Question: State the chart type depicted above.
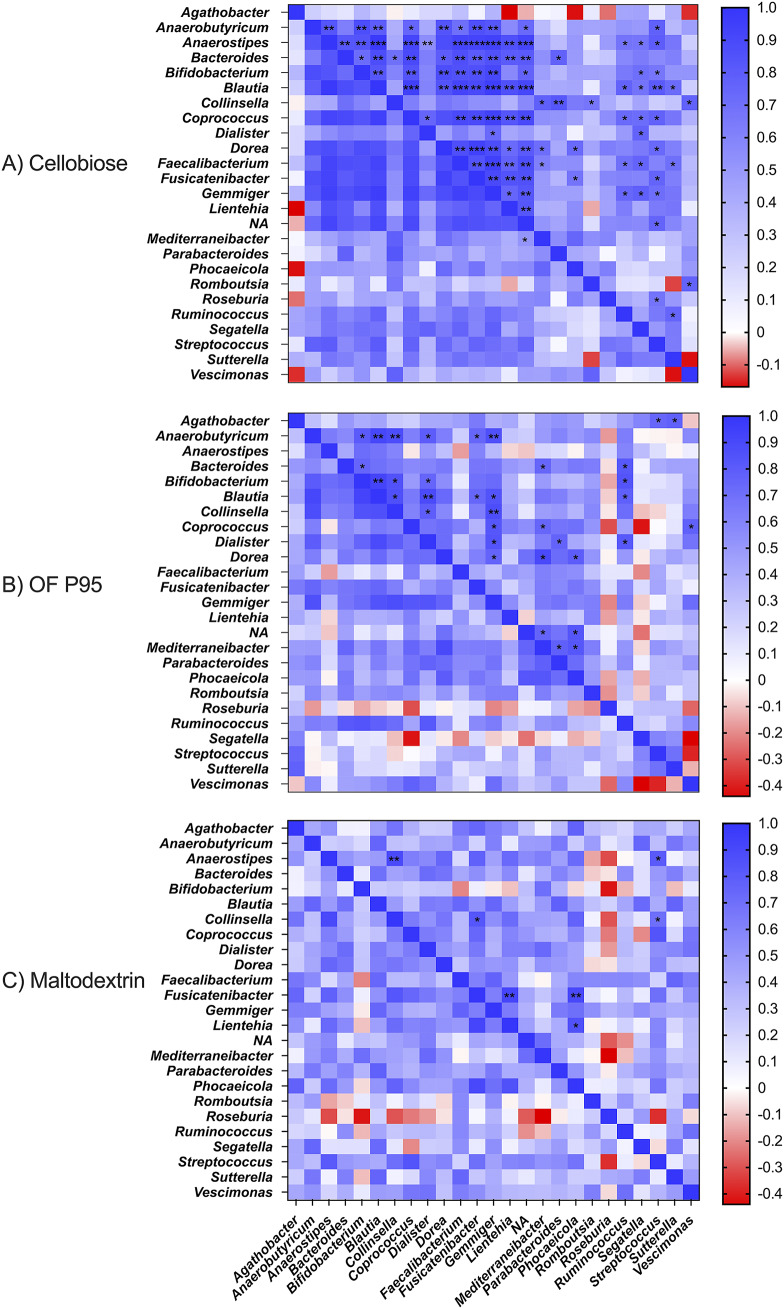
Answer: heatmap